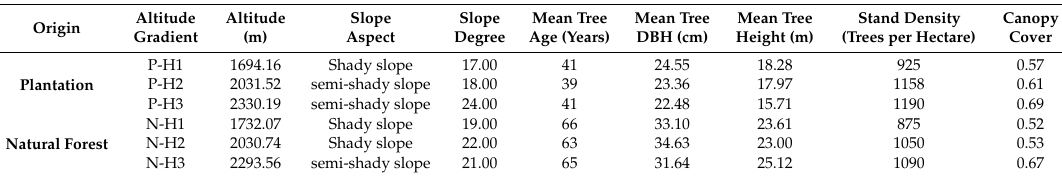
Table 1. Characteristics of study stands on Guandishan Mountain, Shanxi,